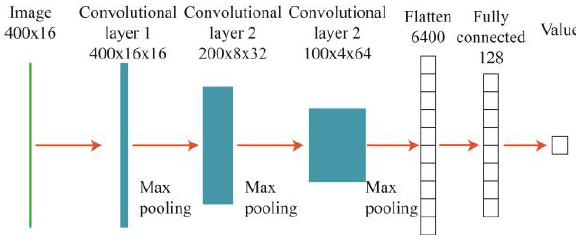
Fig. 2. Structure of neural